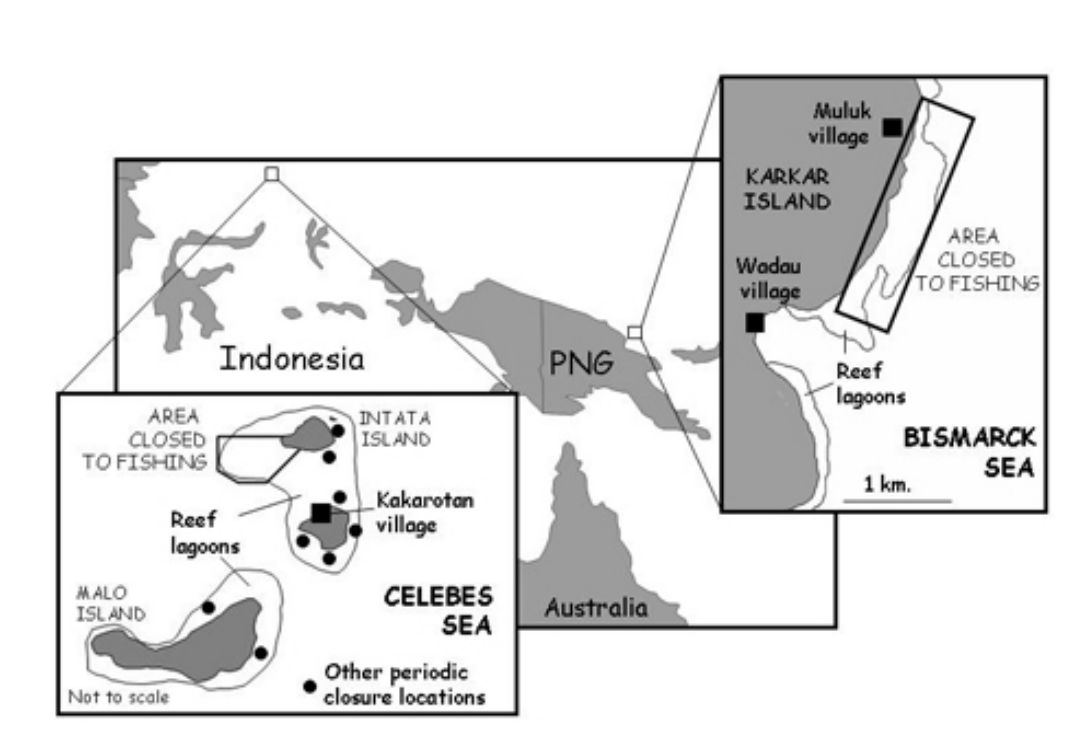
Fig. 1 . Map of study sites and periodic closures